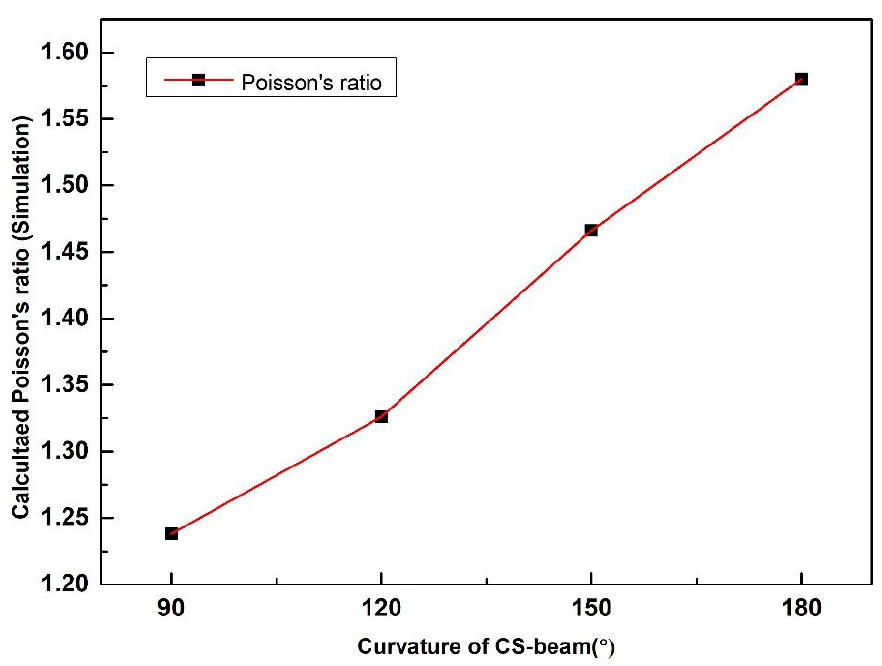
Figure 5. Calculated Poisson’s ratio (absolute value) of CS-based units with di ff erent CS-beam curvature based on simulation.